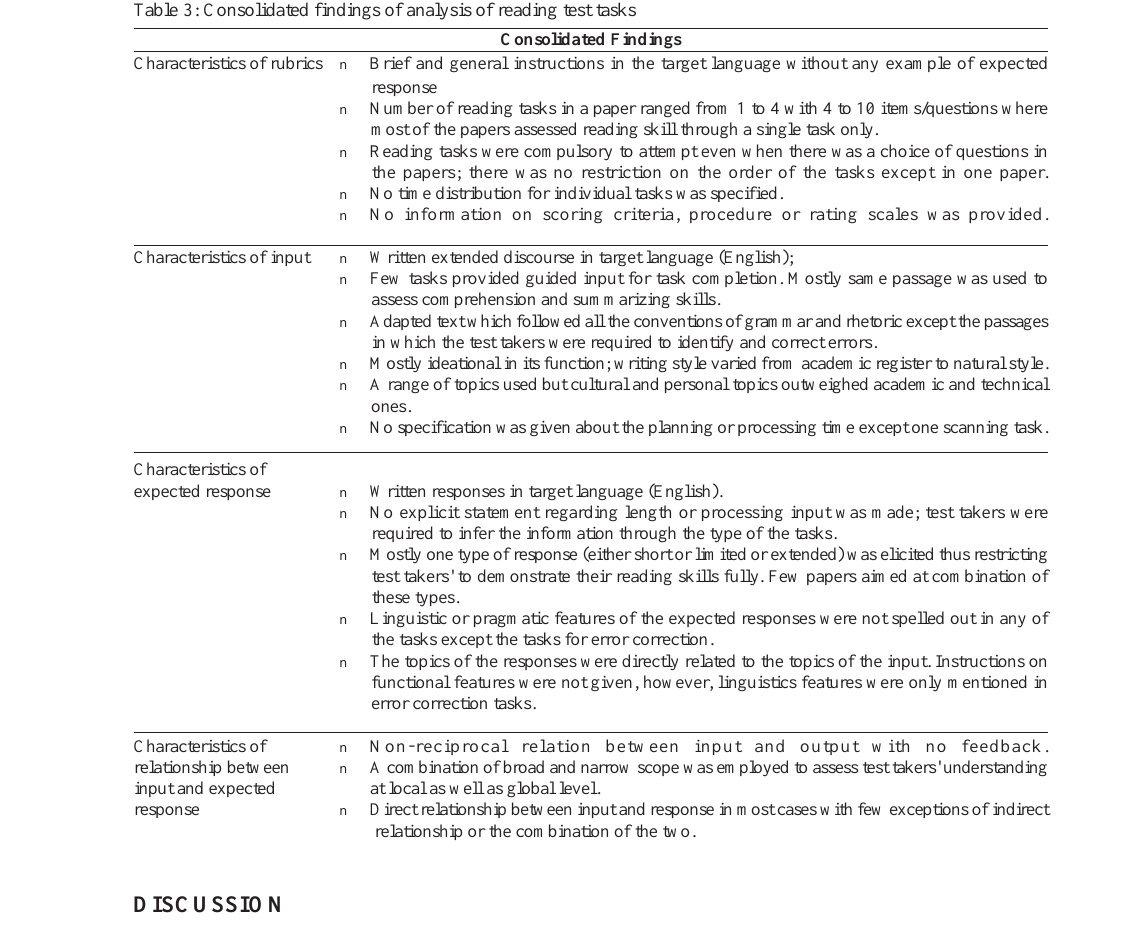
Table 3: Consolidated findings of analysis of reading test tasks Consolidated Findings Characteristics of rubrics n Brief and general instructions in the target language without any example of